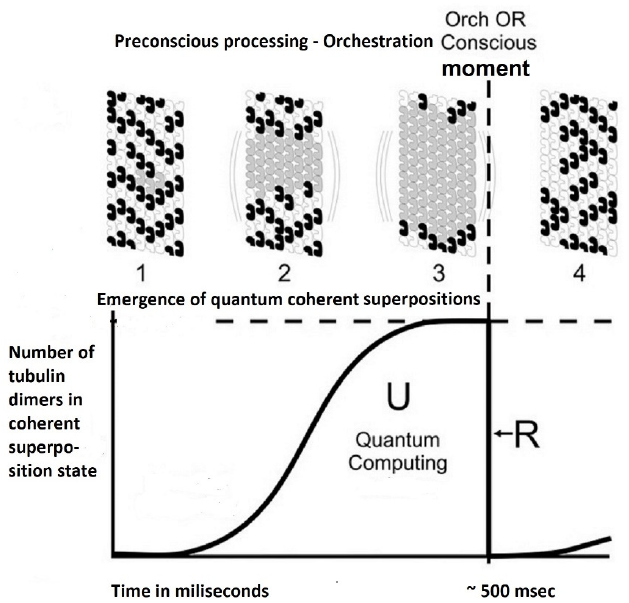
Figure 5. Symbolic illustration of the essence of Roger Penrose and Stuart Harmeroff’s ‘Orch OR’ theory. The authors assume that in the microtubules of neurons repetitive, cyclic quantum information processing is realized, which consists in increasing the quantum coherence of the tubulin dimers, interrupted by the OR operation, causing the conscious moment. In larger synchronized sets of neurons, the termination of orchestration by OR moment occurs after approx. 300 to 500 ms. It is generally known that the activity of the neural network is synchronized. The registration of EEG waves in the alfa, gamma, delta range is a manifestation of this syn- chronization. Large amounts of data have also already been collected on the synchronous operation of neurons in different, sometimes distant centers of the brain, but active in the course of specific, distinguished activities. It is assessed by measurements of so-called connectivity [34–38]. The authors of the theory consider the phenomena, which could be responsible for this synchronization. They emphasize the role of gap junctions, which exist between adjacent neurons. They assume that quantum states in the microtubules of a neu- ron can be enhanced by entanglements and tunneling through the gap junctions of adja- cent neurons. They cite evidence that gamma waves, the known correlate of conscious- ness, rely on gap junctions. They also assume that spatially separated microtubules of dif- ferent neurons can be quantum entangled. Thus, Hameroff and Penrose ground the pro- cess of the emergence of consciousness not only in the quantum processing of data in mi- crotubules, but also in achieving synchronization of neuronal activity in vast stretches of the brain. People becoming acquainted with the ‘Orch OR’ theory face the same difficulty as readers studying works on quantum physics. It is known that physicists continue disputes regarding the problem of the so-called reduction of the wave function {9}. It should be noted that Stuart Hameroff and Roger Penrose propose some personal beliefs in the frame of the “Orch OR” theory. They tried to replace the term “acquiring coherence” with the words “achieving or- chestration”. Roger Penrose also proposed his own concept of wave function reduction, which he termed “objective reduction” (OR). He claims that ‘OR’ occurs spontaneously “due to an objective threshold in the fine-scale structure of the universe at time t = ħ /EG, where ħ is the Planck-Dirac constant, and EG the gravitational self-energy of the super- position” [33].